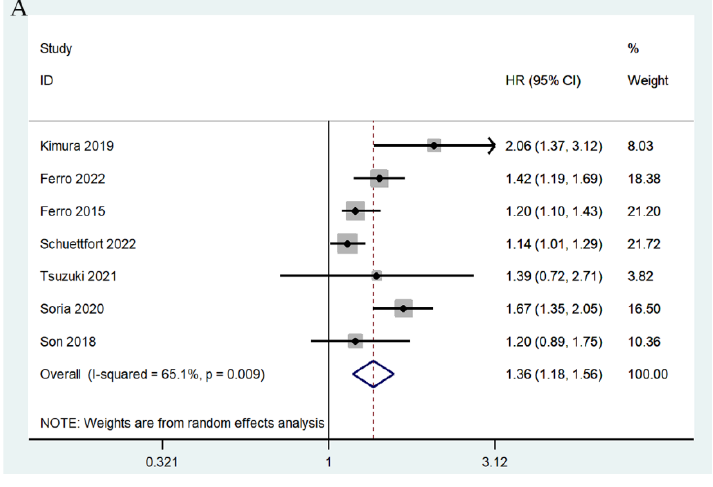
Figure 5. Forest plots of relationship between mGPS and RFS in patients with urothelial carcinoma: ( A ) mGPS 1 vs. 0; ( B ) mGPS 2 vs. 0 [17,24,25,27,28,31,33]. 3.6. mGPS and CSS Seven studies involving 9484 patients reported the relationship between mGPS and CSS [17,22,25,27,28,31,32]. The summary analysis showed that the association was not sta ‐ tistically significant between a score of 1 and poor CSS (mGPS 1/0: HR = 1.25, 95% CI 0.93– 1.68, p = 0.133) (Figure 6A), but there was a significant association between high score and poor CSS before treatment (mGPS 2/0: HR = 1.81, 95% CI 1.30–2.52, p < 0.0001; mGPS high/low: HR = 2.31, 95% CI 1.58–3.37, p < 0.0001) (Figure 6B,C).